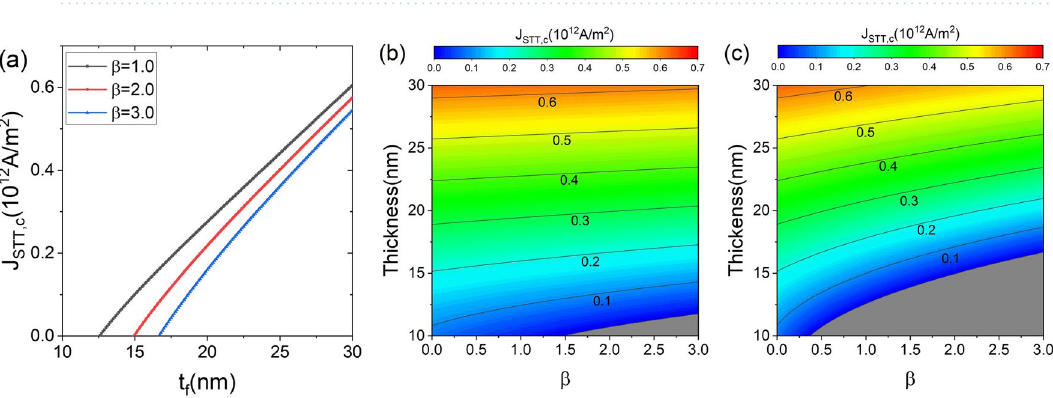
Figure 4. Thickness and spin-orbit field-like torque dependence of J STT,c for fixed diameter = 10 nm. ( a ) J STT,c as a function of t f for different β and fixed J SOT = 6.0 × 10 12 A/m 2 . ( b ) and ( c ) J STT,c as a function of t f and β for a given J SOT = 3.0 × 10 12 A/m 2 ( b ) and J SOT = 6.0 × 10 12 A/m 2 ( c